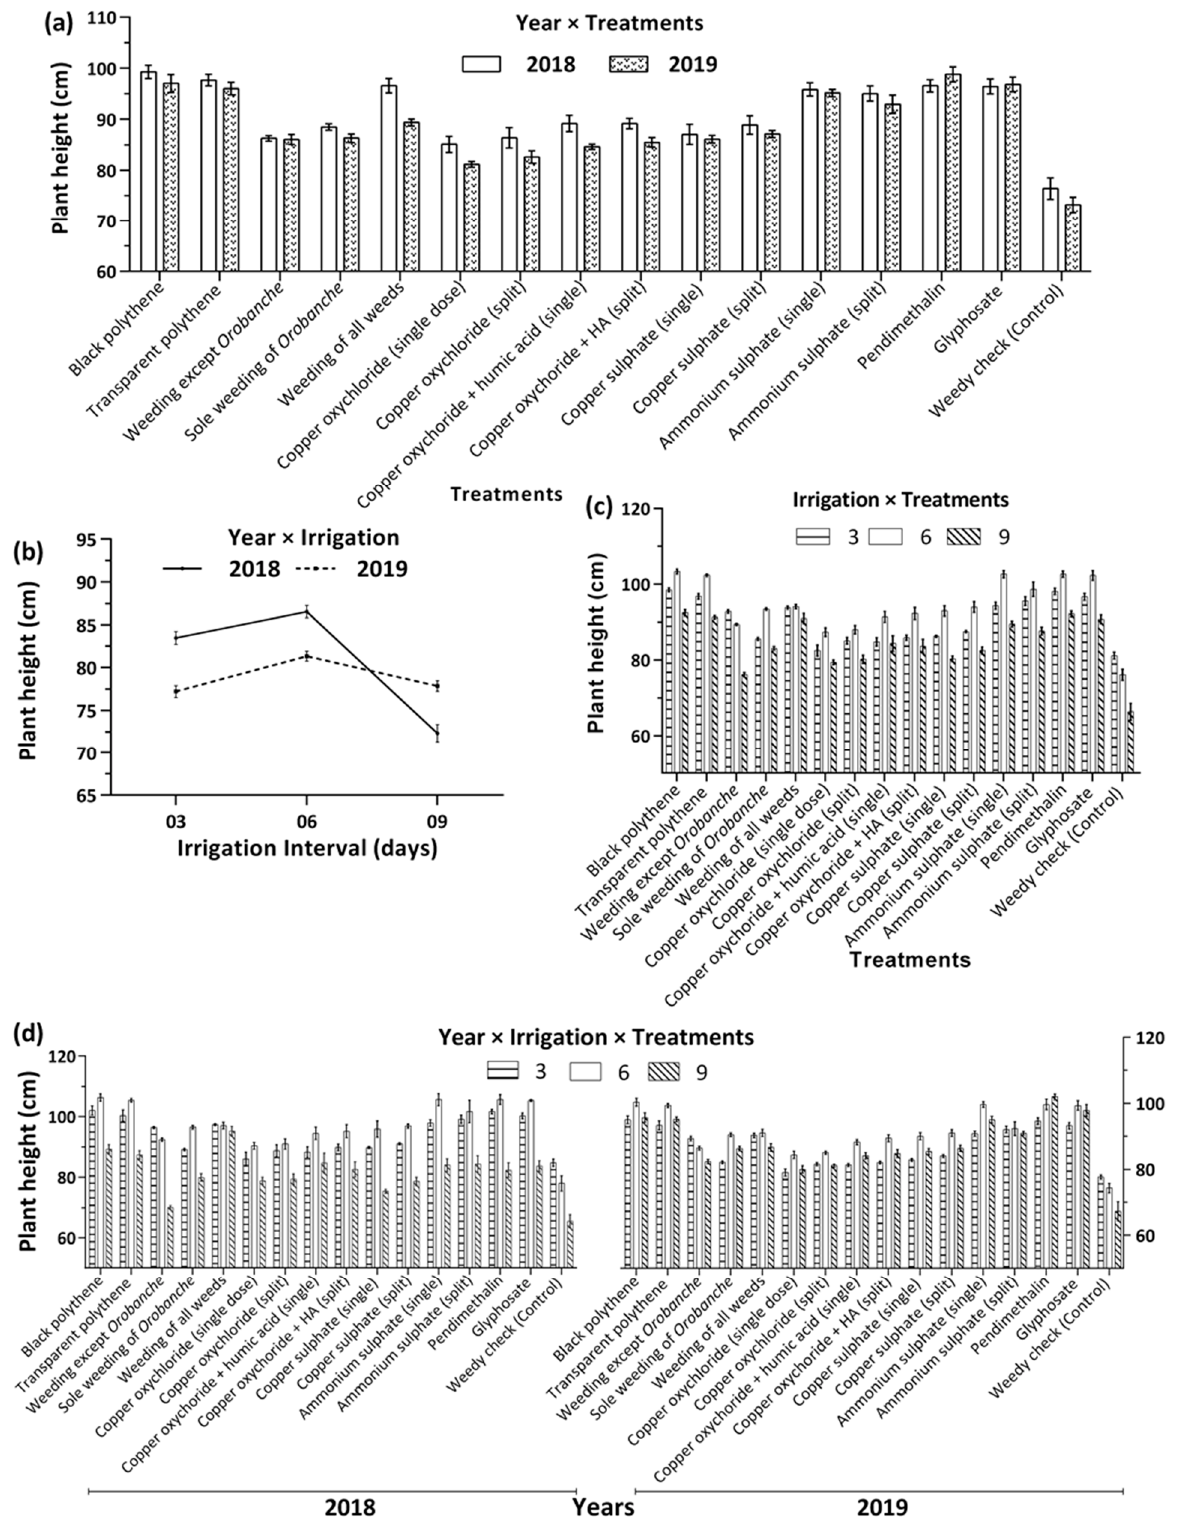
Figure 10. Influence of various interactions on plant height of tomato. ( a ) Interaction effect of year × treatments on plant height of tomato. ( b ) Interaction of year × irrigation effect on plant height of tomato. ( c ) Interaction effect of irrigation × treatments on plant height of tomato. ( d ) Interaction of year × irrigation × treatments on plant height of tomato.